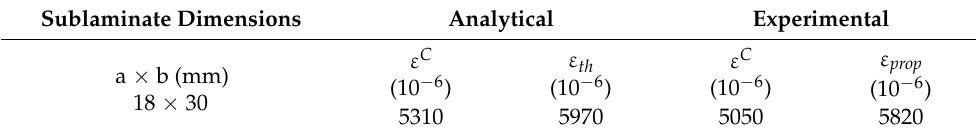
Table 4. Summary of analytical and experimental results for buckling and threshold strains for the fourth